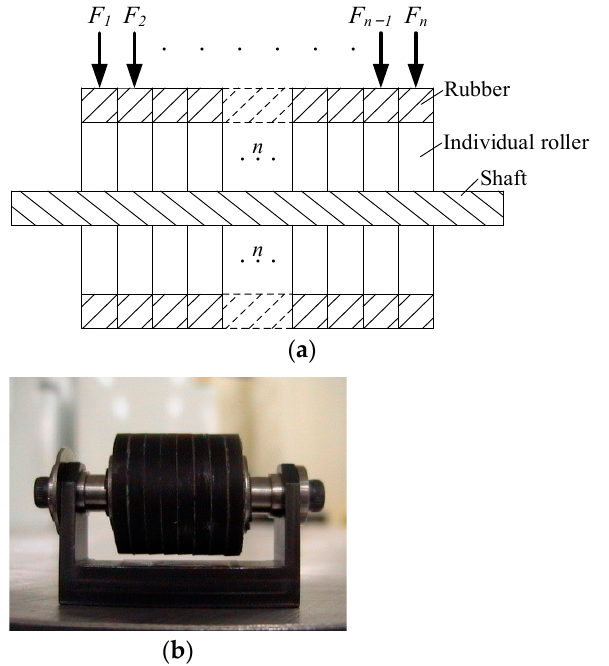
Figure 5. The multi-piece compaction roller. ( a ) The optimized compaction roller with 𝑛 individual roller components. ( b ) The multi-piece compaction roller for the experiment.